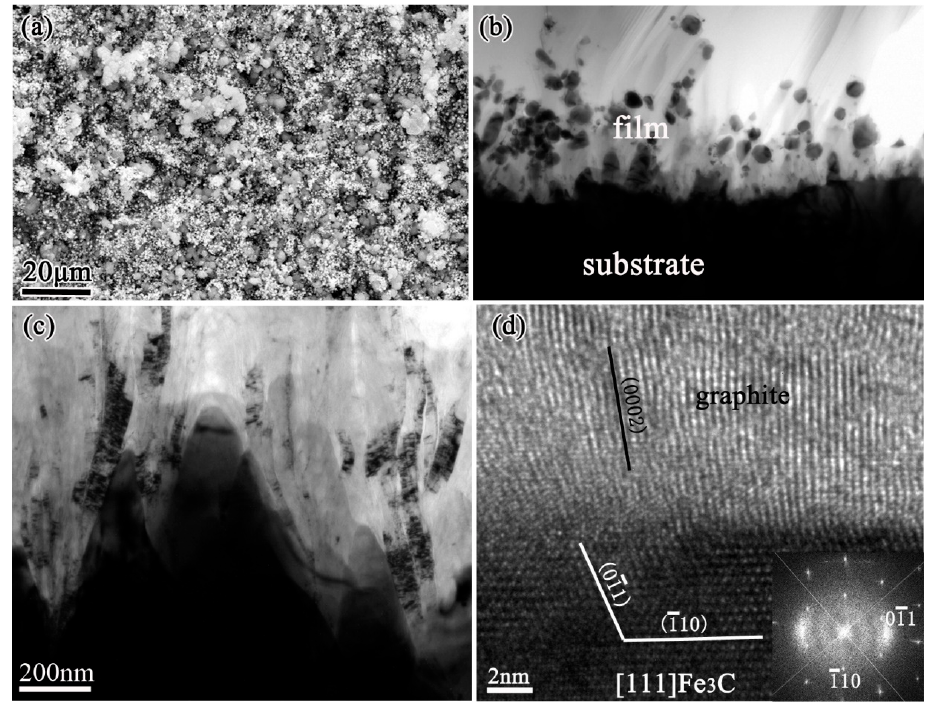
Figure 1. A thick graphite layer formed on iron substrate before diamond deposition: ( a ) scanning electron microscope (SEM) image, ( b , c ) cross-sectional transmission electron microscope (TEM) images of the interface between iron substrate and graphite layer, showing the graphite precipitated at the surfacial grooves of iron substrate. ( d ) High-resolution TEM (HRTEM) image from these grooves, with the corresponding Fast Fourier Transform (FFT) inserted. (Reproduced with permission from [20]).